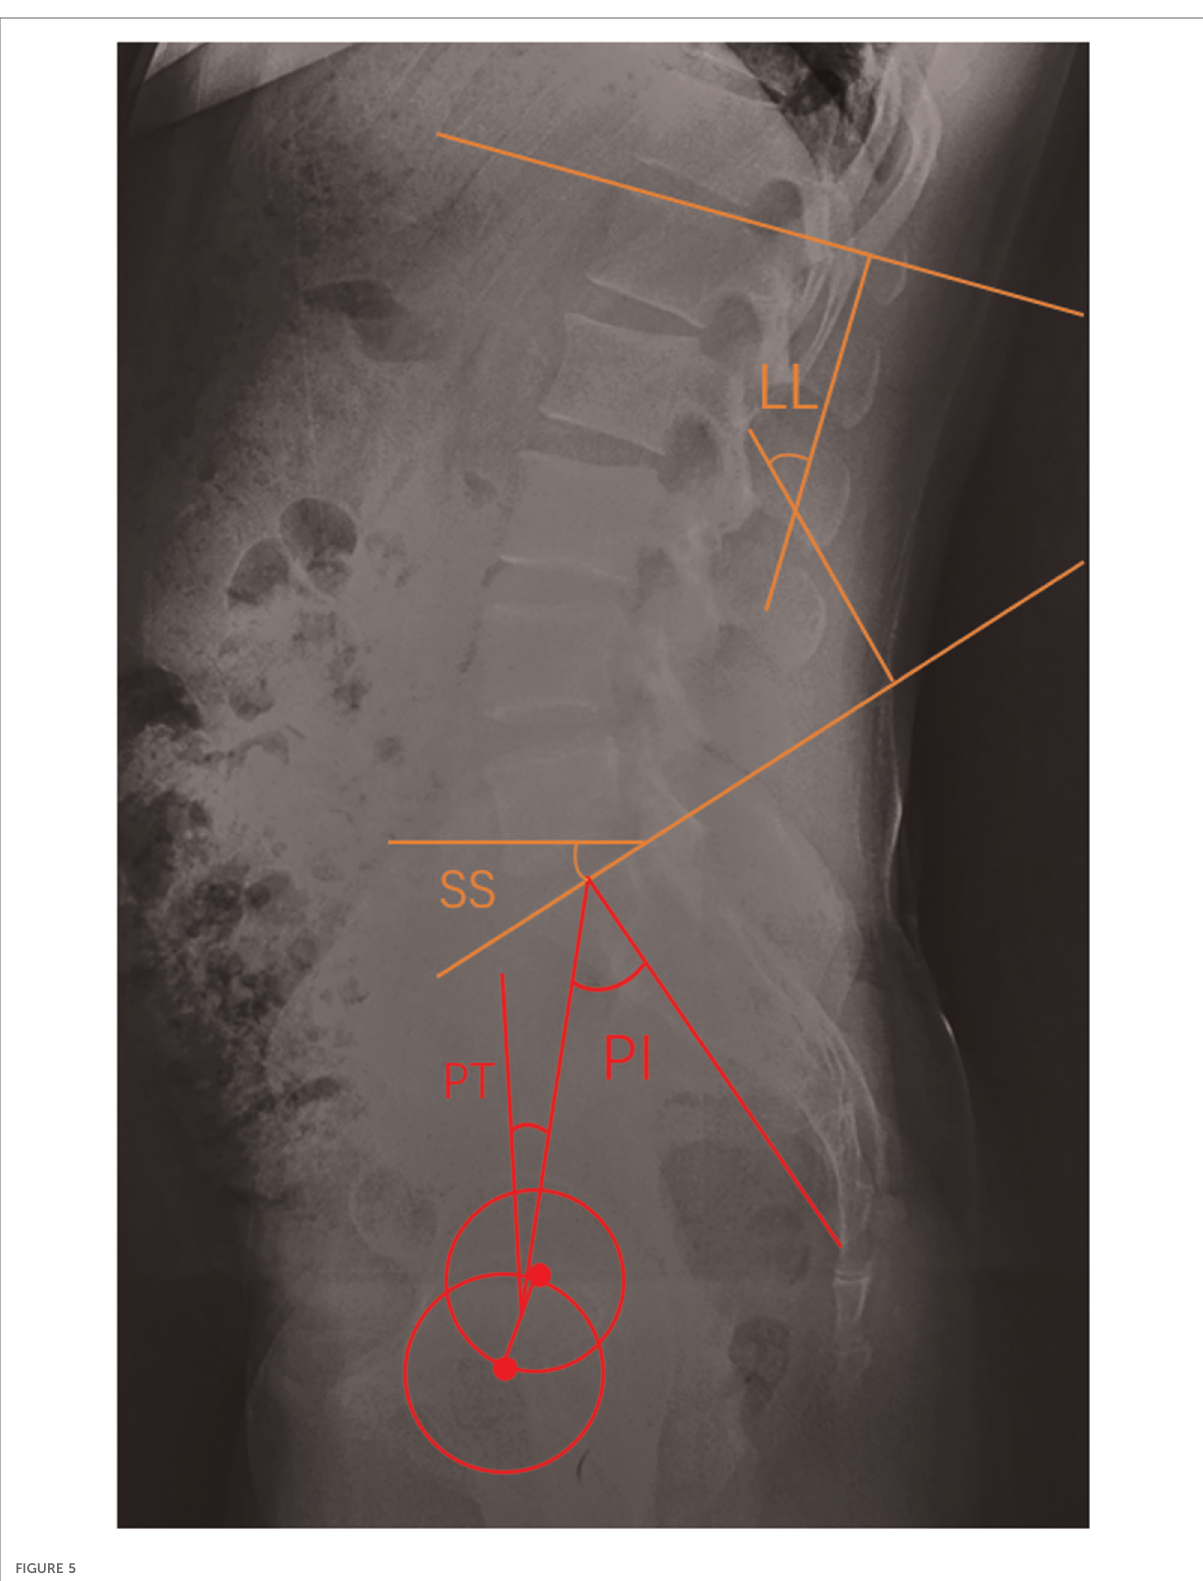
FIGURE 5 The lumbosacral sagittal parameters, included PI, PT, LL and